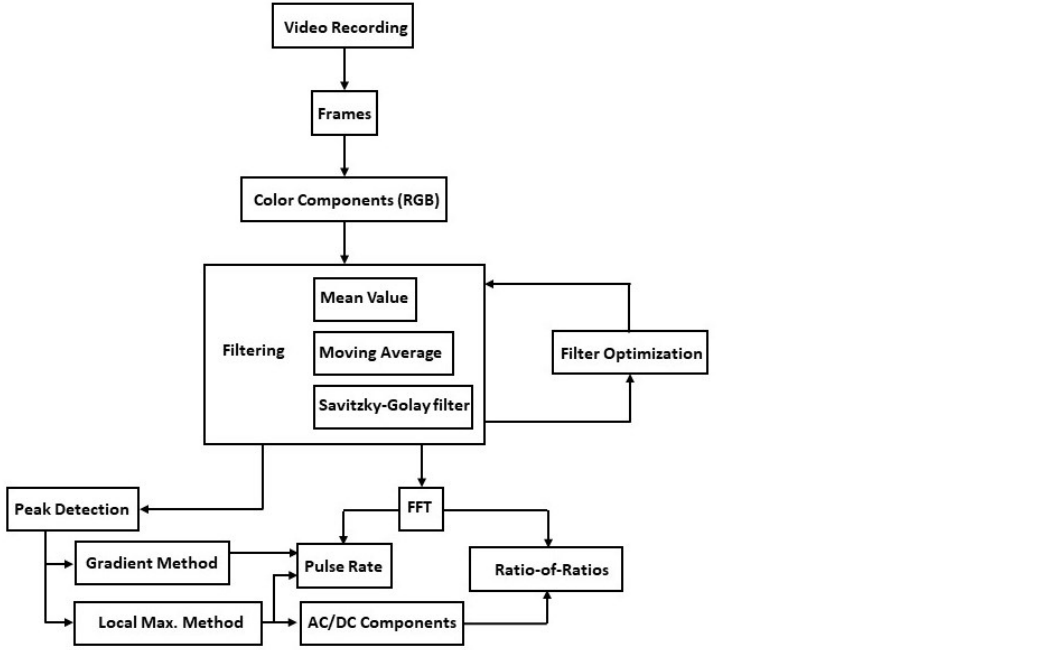
Figure 1. Flowchart of the methodology used to obtain pulse rate and